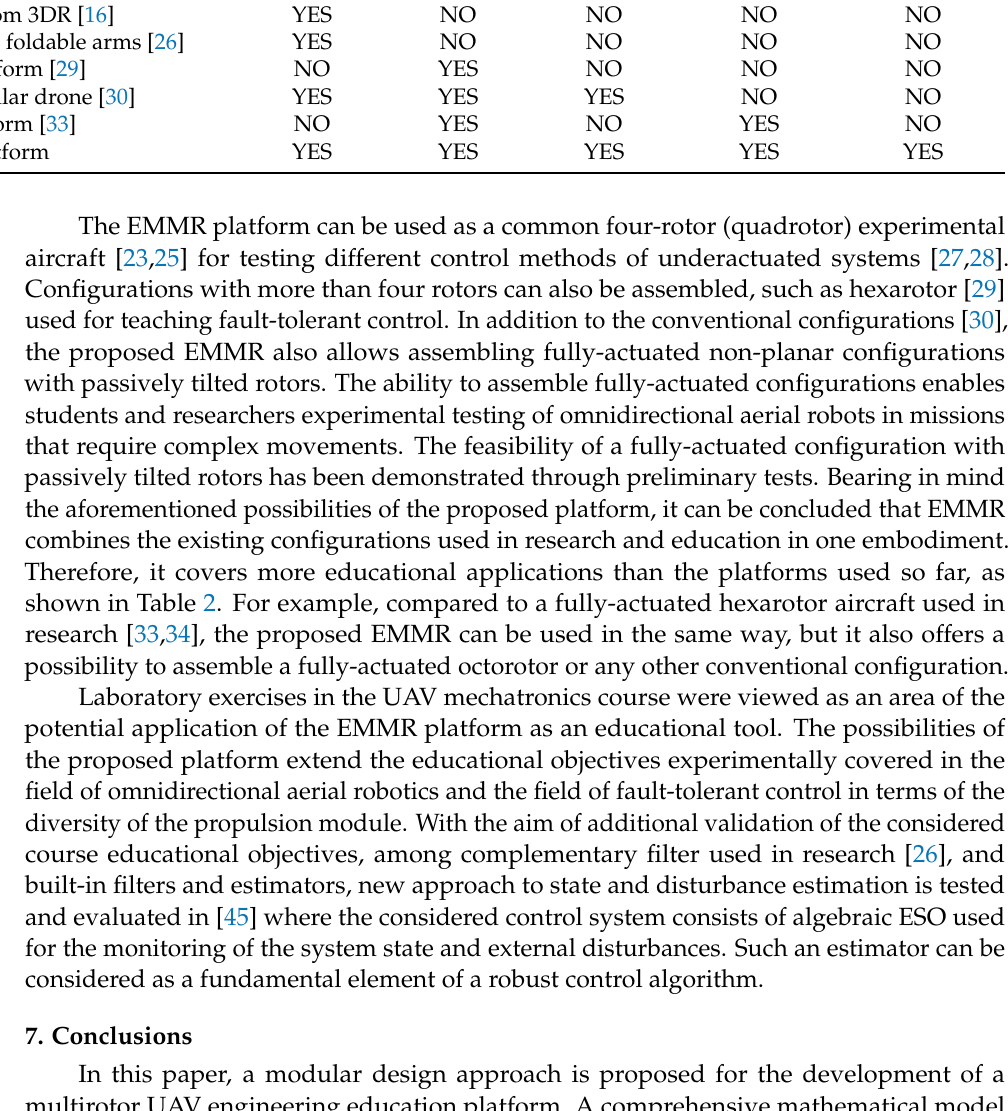
Table 3. Comparison of commercial, experimental, and conceptual platforms. Platform